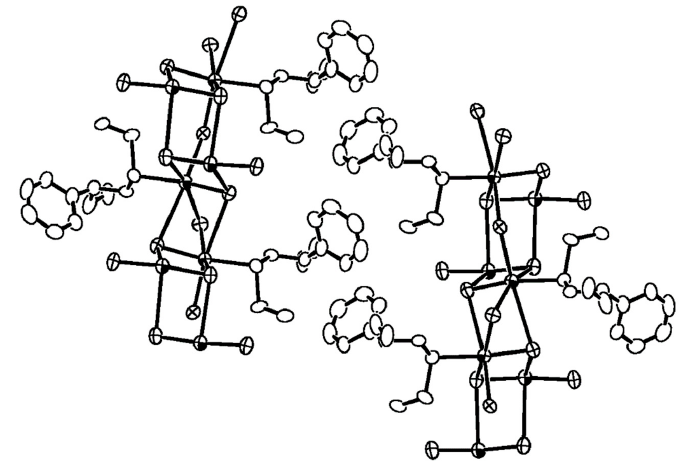
Figure 3. Packing arrangement of ( II ), showing interdigitation of organic moieties in the assembly of polymeric polymeric ribbons.